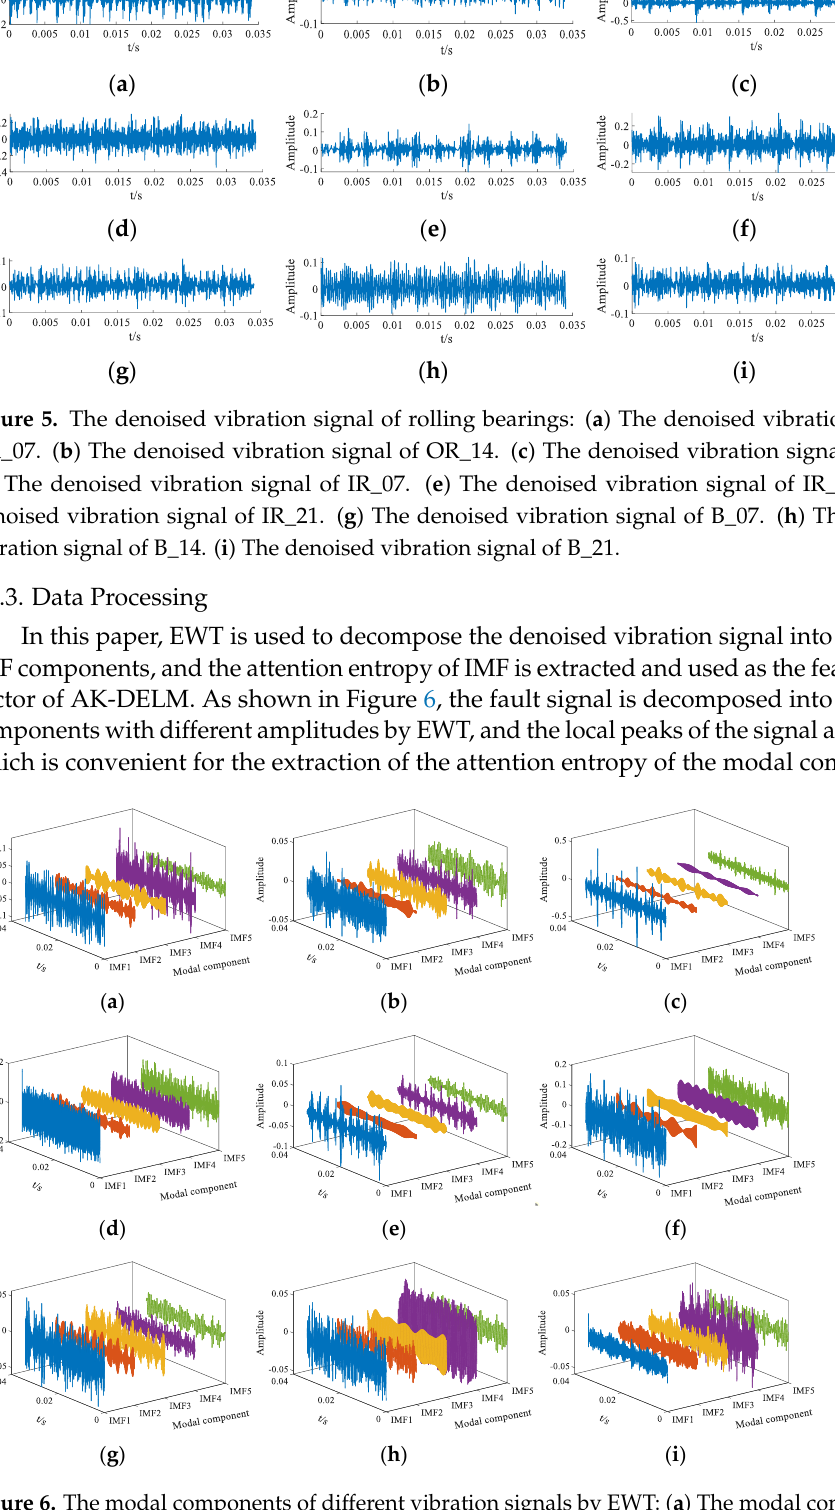
Figure 6. The modal components of different vibration signals by EWT: ( a ) The modal components of OR_07 by EWT. ( b ) The modal components of OR_14 by EWT. ( c ) The modal components of OR_21 by EWT. ( d ) The modal components of IR_07 by EWT. ( e ) The modal components of IR_14 by EWT. ( f ) The modal components of IR_21 by EWT. ( g ) The modal components of B_07 by EWT. ( h ) The modal components of B_14 by EWT. ( i ) The modal components of B_21 by